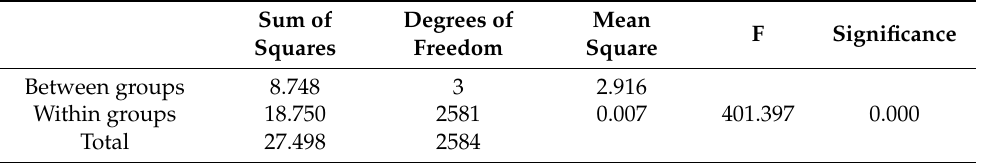
Table A5. Statistical analysis of ANOVA for the key wavelength of 823 nm for the four excess nitrogen